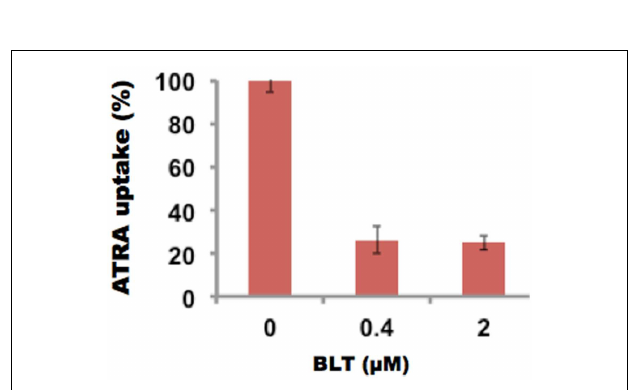
FIGURE 8 | Inhibition ofATRA uptake by SMS-KCNR (neuroblastoma) cells via the SR-B1 inhibitor BLT.